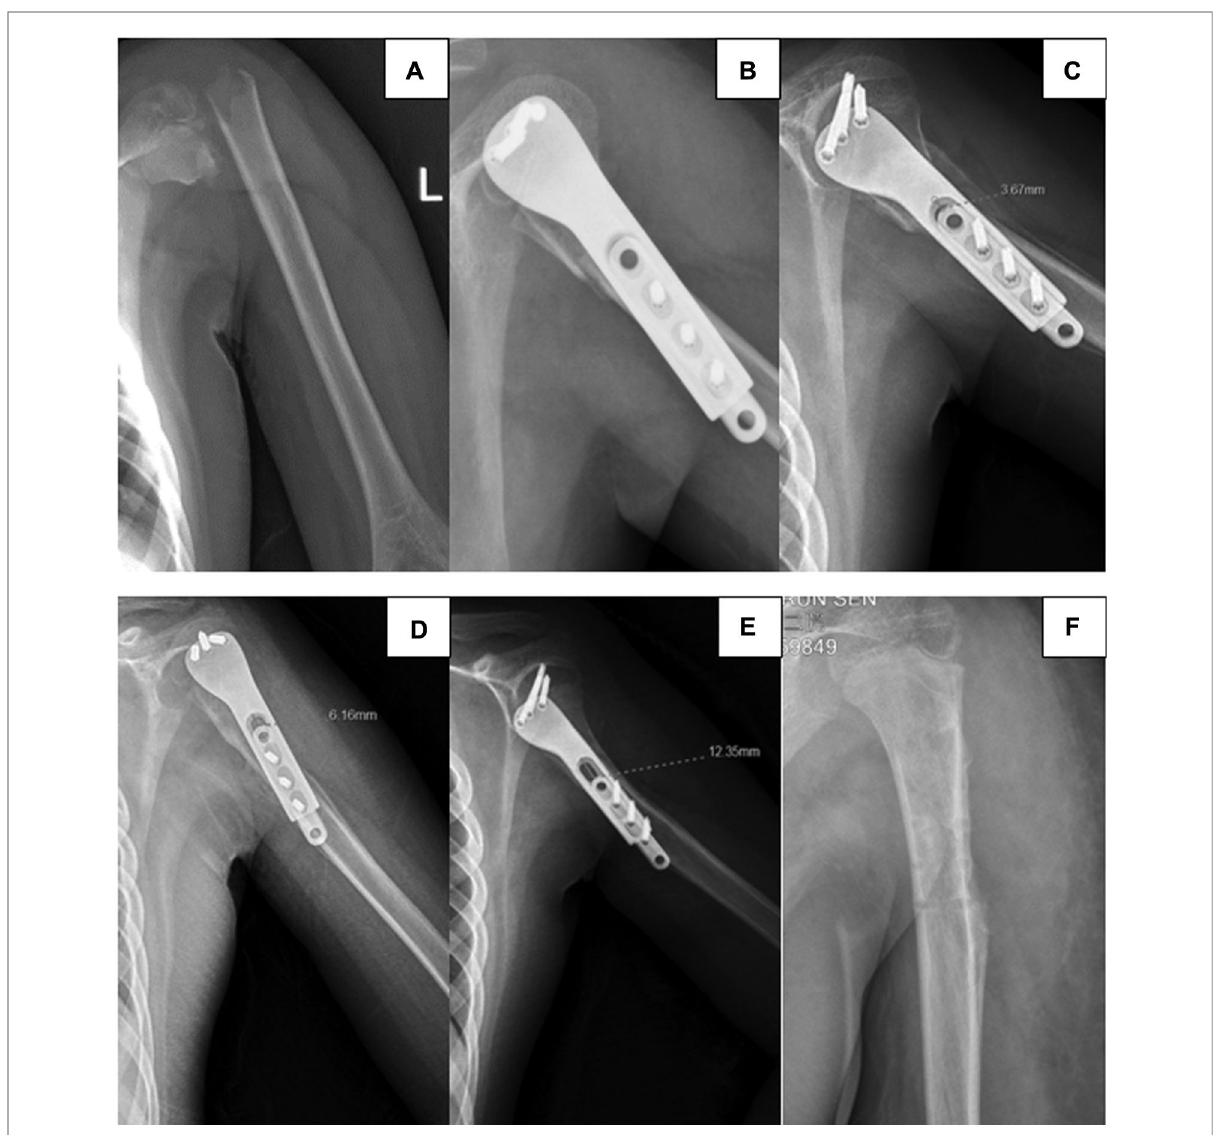
weeks after surgery. ( D ) Lateral radiography at 3 months after surgery. ( E ) Lateral radiography at 6 months after surgery. ( F ) Postoperatively, slide plate